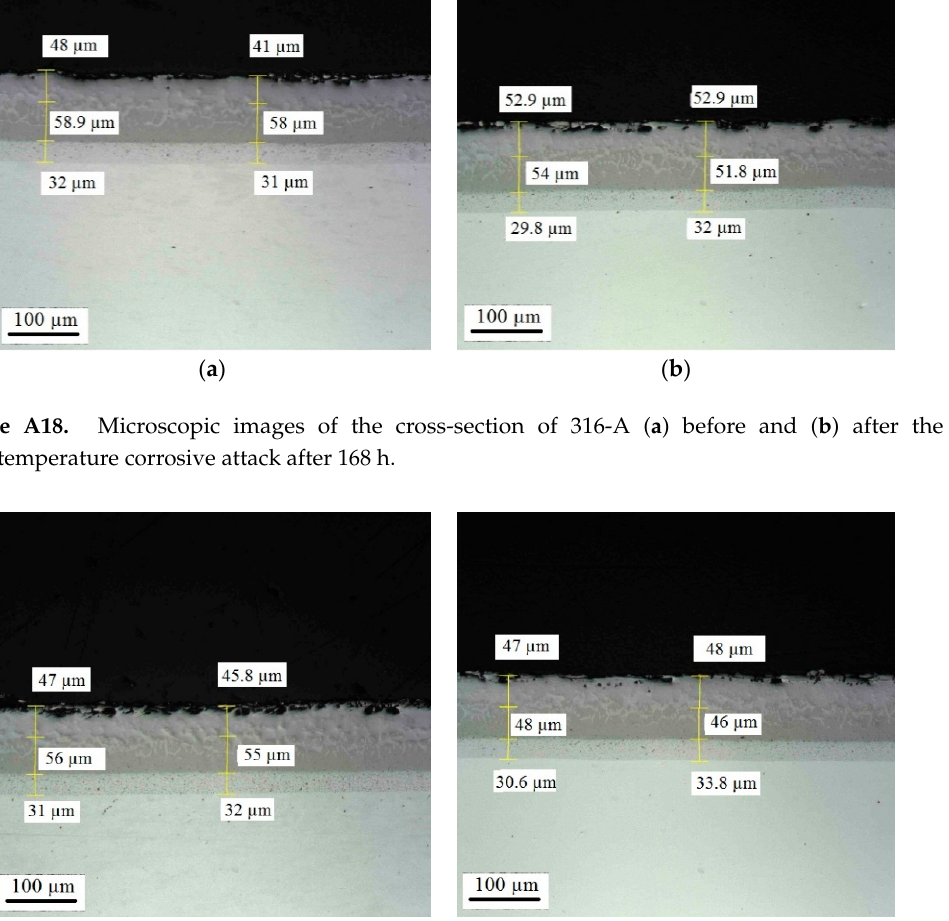
Figure A19. Microscopic images of the cross-section of 316-A-Sn ( a ) before and ( b ) after the high-temperature corrosive attack after 168 h.